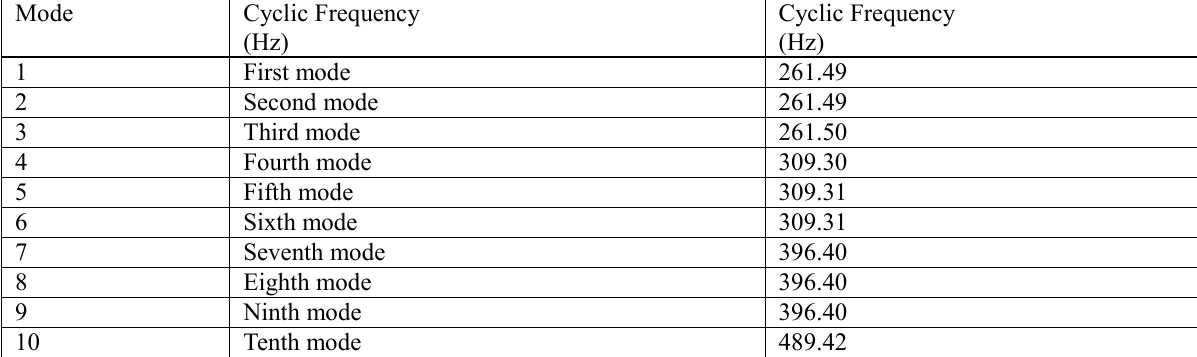
Fig. 8(i) 1 st Torsional Mode. Fig. 8(j) 2 nd Lateral